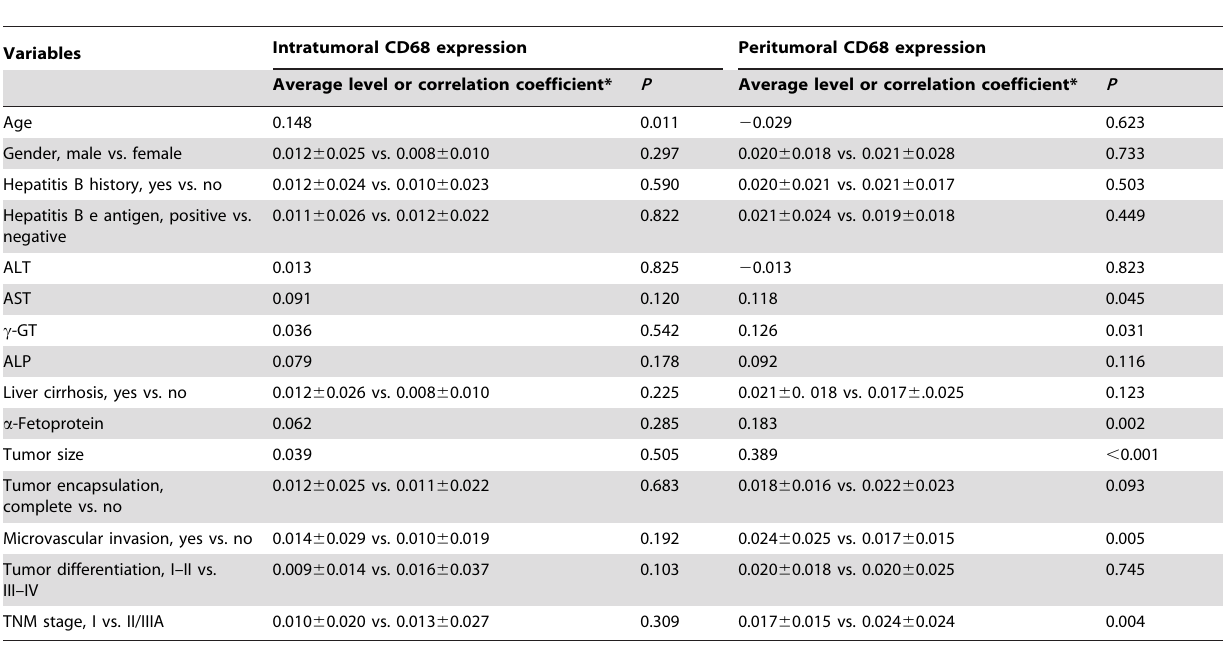
Table 3. Relationships between intratumoral/peritumoral CD68 expression and clinicopathologic features.